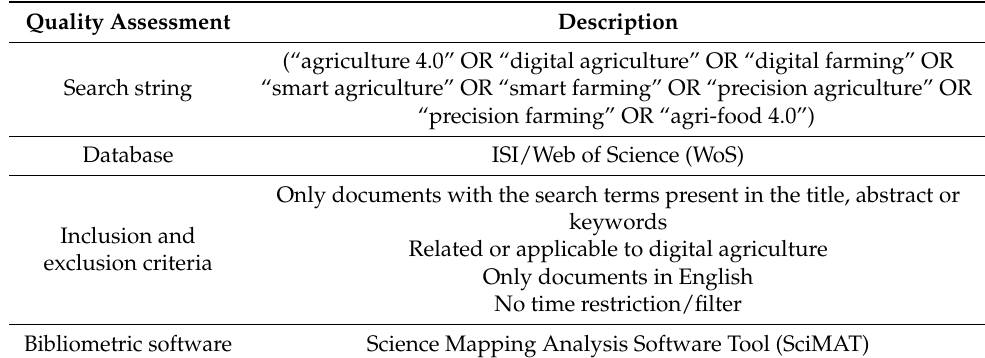
Table 2. Quality assessment